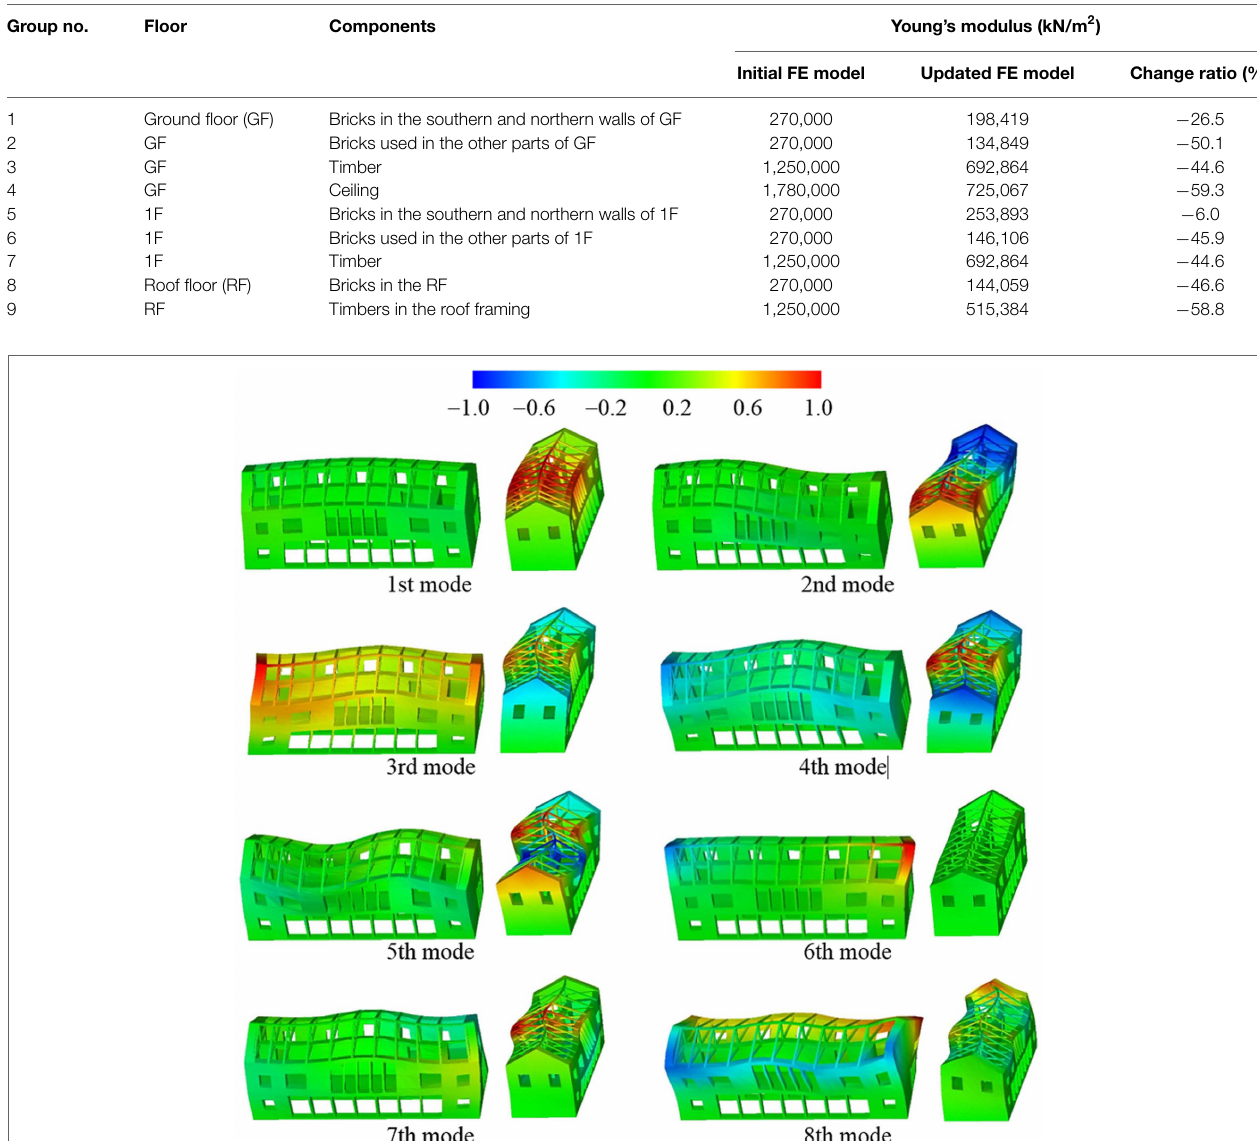
TABLE 6 | Results of stiffness updating for the building before the earthquake: comparison of Young’s modulus between initial and updated finite element model. Group no.